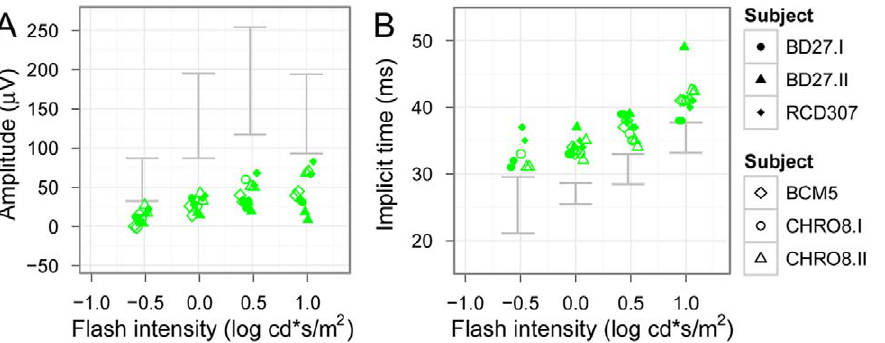
Figure 8. Intensity-response function kinetics under photopic conditions. Photopic response b-wave amplitudes are shown in (A) and implicit times in (B), the 95% confidence band of normal subjects is marked with grey. The photopic hill phenomenon can be observed in normals, however, this phenomenon seems to be missing in patients. Implicit times in both patient groups are moderately delayed (upper subjects: NOP group, lower subjects: ALP